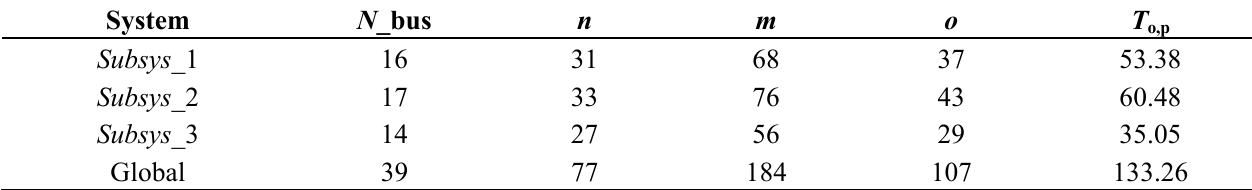
Table 7. Decomposition of IEEE 14-bus